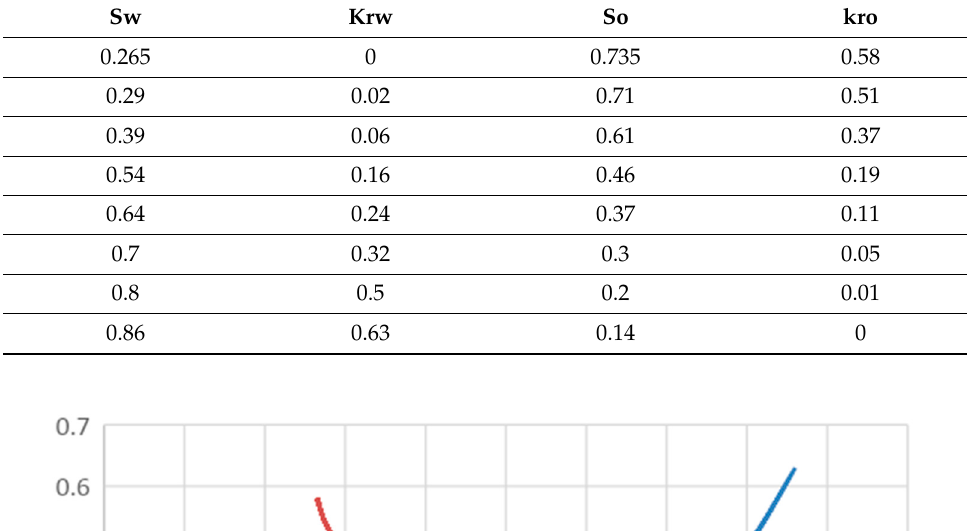
Table A6. Relative Permeabilities and Saturations.